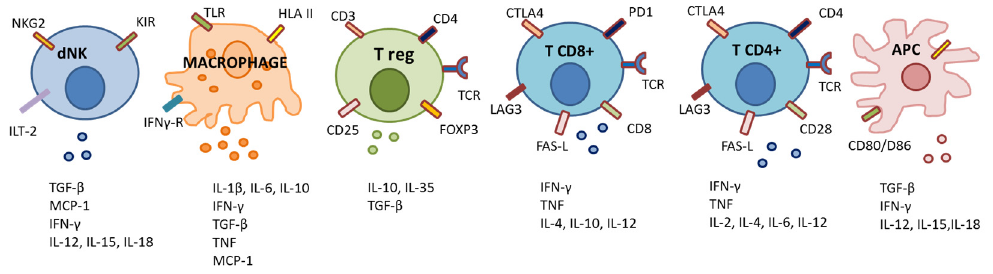
Figure 3. Main immune cells involved in immune tolerance at feto-maternal interface. APC: antigen presenting cell; CTLA4: cytotoxic T-lymphocyte associated protein-4; dNK: decidual natural killer cell; HLA: human leukocyte antigen; IL: interleukin; ILT-2: immunoglobulin-like transcript 2 receptor; IFN: interferon; KIR: killer cell Ig-like receptors; LAG3; lymphocyte activation gene-3; MCP: monocyte chemoattractant protein; NKG2: natural killer group 2 receptor; PD1: programmed cell death 1; TCR: T cell receptor; TGF: transforming growth factor; TLR: toll-like receptor; TNF: tumor necrosis factor.